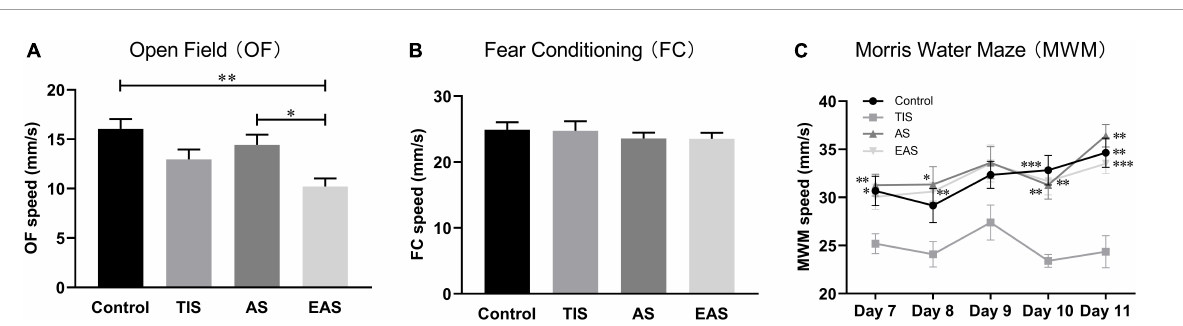
FIGURE3 Locomotion among behavioral tests. (A) In OF, the average speed of mice exploring after extended abdominal surgery was significantly lower than that in controls and abdominal surgical mice. (B) In the FC, there were no significant differences between groups. ∗ , ∗∗ vs. group EAS. (C) In the MWM, the swimming speed of tibial fracture mice was significantly lower than that of other groups. ∗ , ∗∗ , ∗∗∗ vs. group TIS. Data represent mean ± SEM ( n = 9–12 per group). ∗ P < 0.05; ∗∗ P < 0.01; ∗∗∗ P < 0.001.